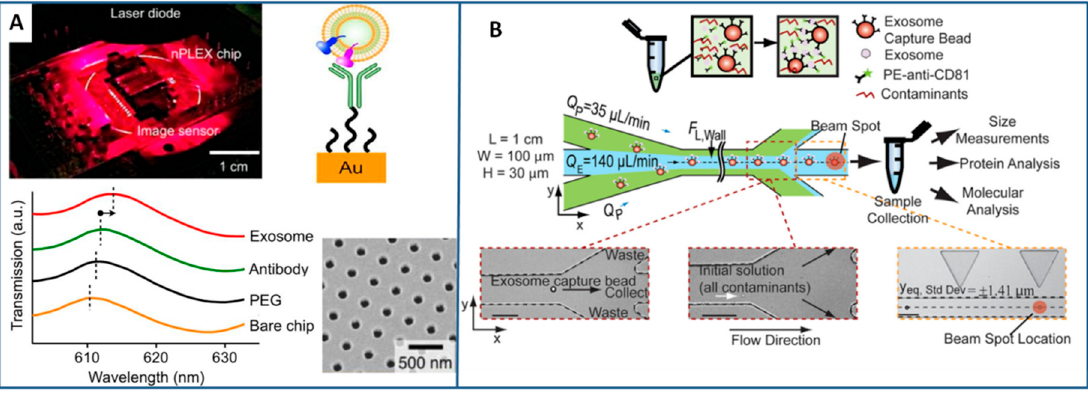
Figure 3. Immunoaffinity strategies to trap exosomes directly on the sensor flat surface or on beads. ( A ) Picture of the nPLEX imaging prototype; a scanning electron micrograph showing the array of nanoholes and the graph revealing changes in transmission spectra due to exosome detection. The sensing interface is functionalized by specific antibodies able to bind exosomes and stabilized by a polyethylene glycol (PEG) layer to minimize nonspecific interactions. Reproduced with permission from reference [136]; ( B ) Exosomes in the biofluid are pre-treated with capture beads. Then, the fluid is injected in the device with a co-flow of tris-buffered saline (TBS) at different volumetric flow rates (Q E and Q P ); beads migrate in the middle of the microchannel and contaminants are siphoned off under the effect of inertial lift forces (F L ). Scale bar: 100 µ m. Reproduced from reference [114], with the permission of AIP Publishing.